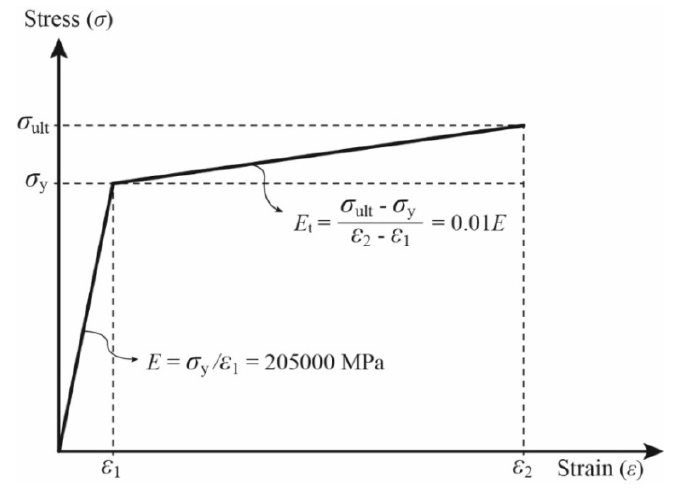
Figure 3. Bilinear steel material model.